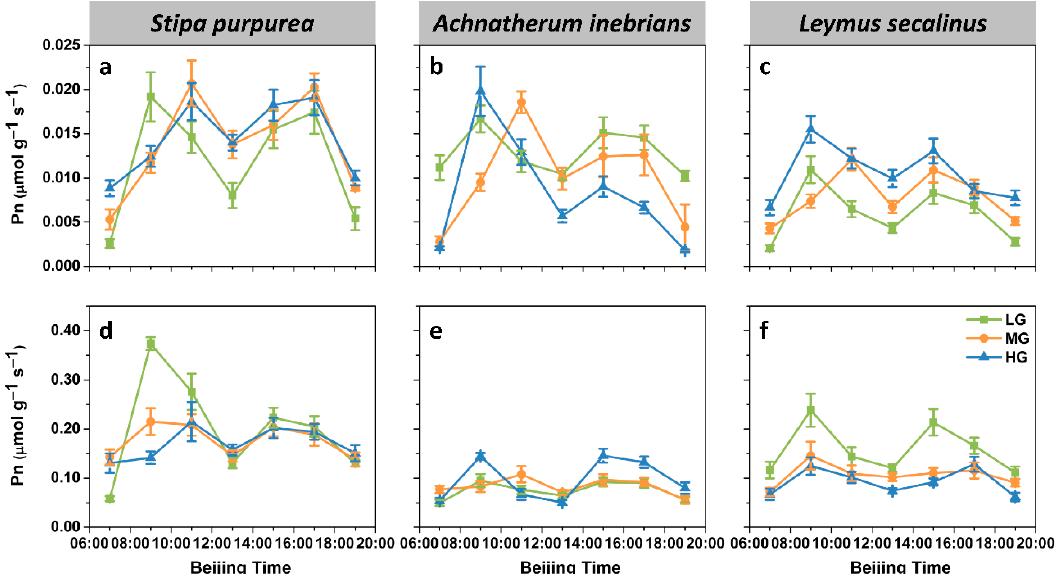
Figure 2. Diurnal dynamics of the net photosynthetic rate (Pn) of the leaves and spikes of S. purpurea ( a , d ), A. inebrians ( b , e ) and L. secalinus ( c , f ) in response to grazing intensity (LG, light grazing; MG, medium grazing; HG, heavy grazing). The data are presented as mean ± standard error (SE) of three independent experiments.